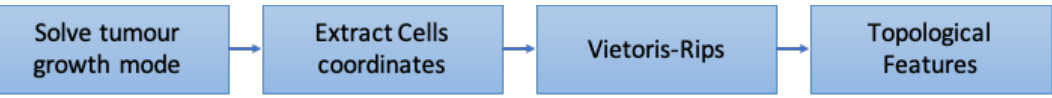
Figure 2. Flowchart depicting the main sequence of steps performed in the first experiment. The steps are documented in the text.